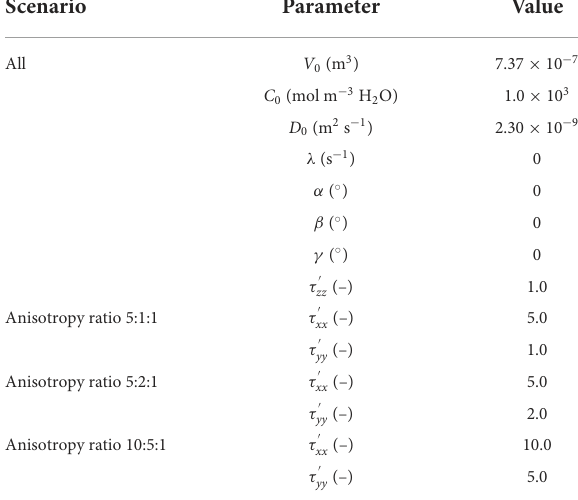
TABLE 2 Model parameters for 3-D anisotropic diffusion verification